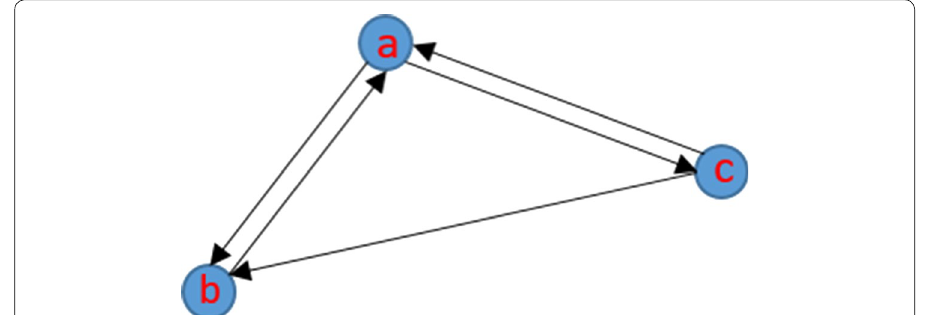
Fig. 2 A directed graph with three